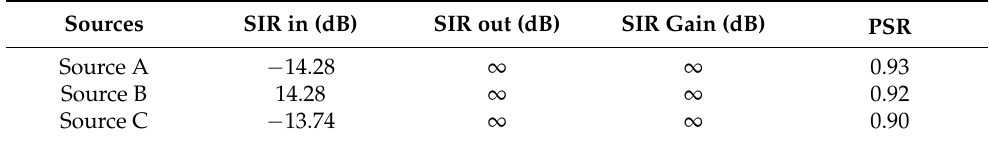
Table 5. The de-mixing performance in the experiments.